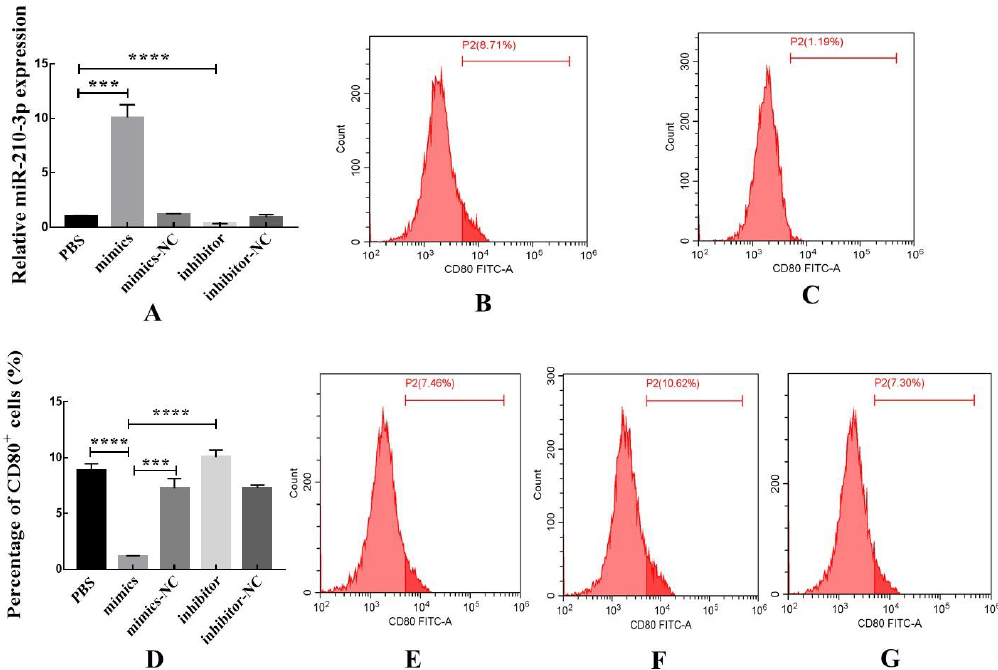
Figure 9. miR-210-3p could decrease the proportion of CD80 + macrophages. ( A ) The transfection efficiency was verified by RT-qPCR. ( B ) The effects of PBS on the proportion of CD80 + macrophages. ( C ) The effects of miR-210-3p mimics on the proportion of CD80 + macrophages. ( D ) The flow cytometry was used to detect the proportion of CD80 + macrophages. ( E ) The effects of miR-210-3p mimics-NC on the proportion of CD80 + macrophages. ( F ) The effects of miR-210-3p inhibitor on the proportion of CD80 + macrophages. ( G ) The effects of miR-210-3p inhibitor-NC on the proportion of CD80 + macrophages. Data are expressed as the mean ± SEM (*** p < 0.0001, **** p < 0.0001).